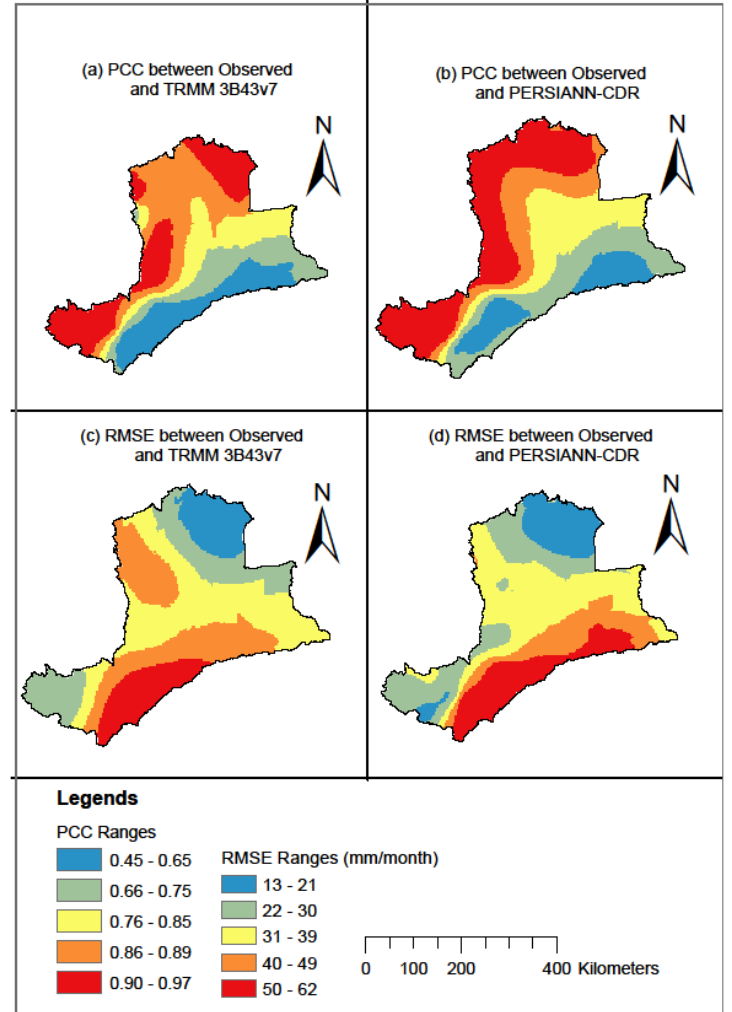
Figure 4. ( a – d ) Pearson correlation coefficient ( PCC ) and root mean square error ( RMSE ) between observed and satellite monthly rainfall data. observed and satellite monthly rainfall